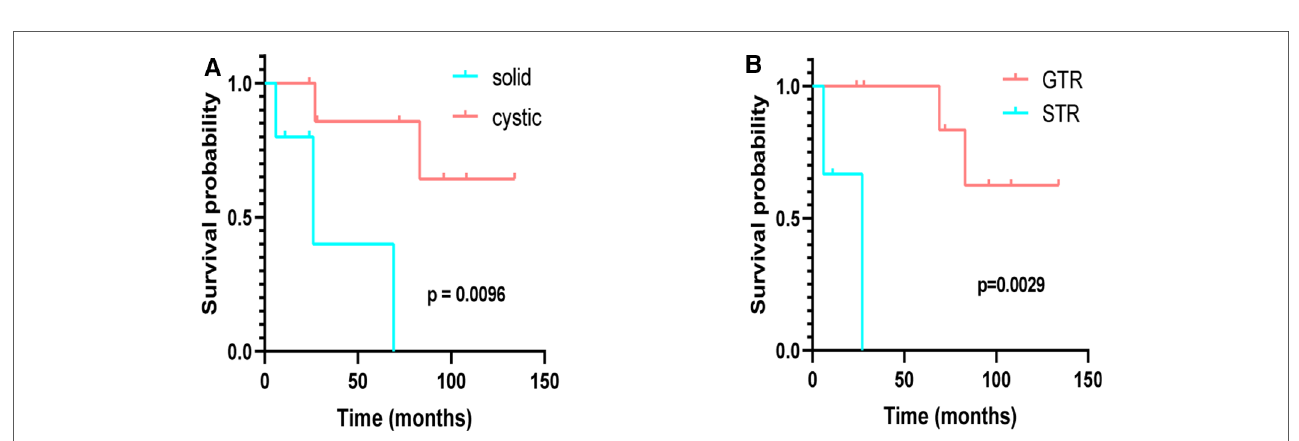
FIGURE 4 Kaplan – Meier analysis of progression-free survival of supratentorial hemangioblastoma strati fi ed by treatment modalities. ( A ) Cystic vs. solid ( p =0.0096); ( B ) GTR vs. STR ( p